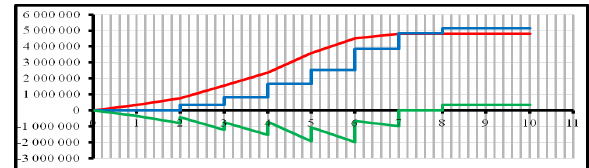
Figure 4: Contractor’s cumulative expenditures, client’s cumulative payments and contractor’s cumulative cash flow in case of bill